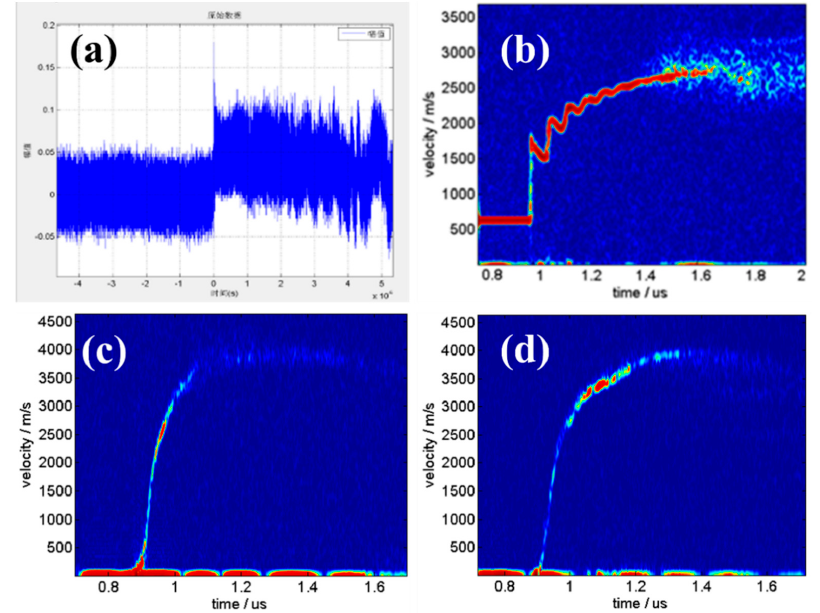
Figure 7. ( a ) The spectrum diagram of the flyer velocity, and the Fourier transform velocity spectrum (2.0 kV) of ( b ) Sample A, ( c ) Sample B, and ( d ) Sample C.